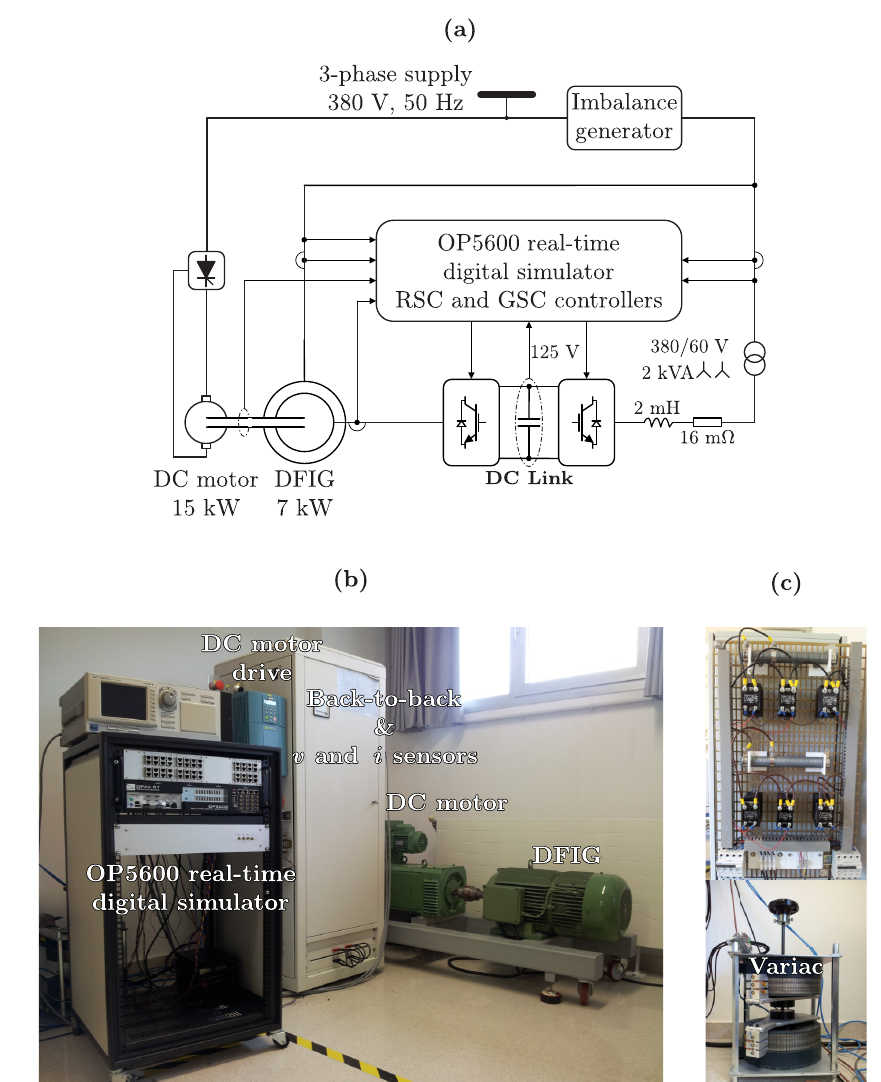
Figure 12. Experimental rig: ( a ) Connection diagram; ( b ) snapshot of the test bench containing the 7 kW DFIG prototype; and ( c ) controlled two-phase imbalance